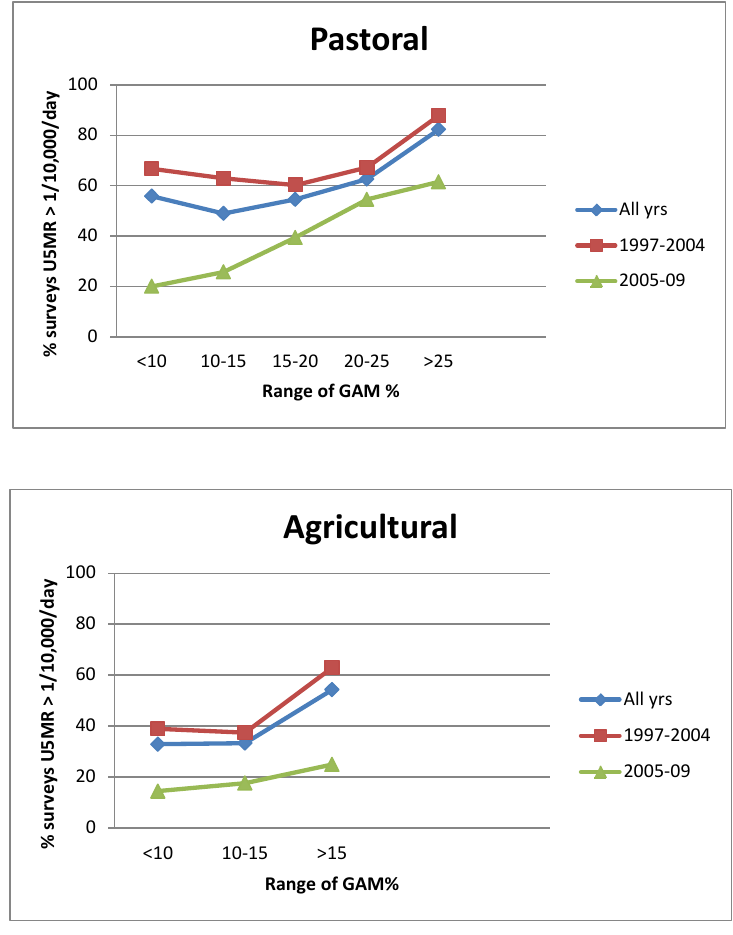
Figure 3. Percentage of surveys with U5MR > 1/10,000/day by range of GAM %, by livelihood